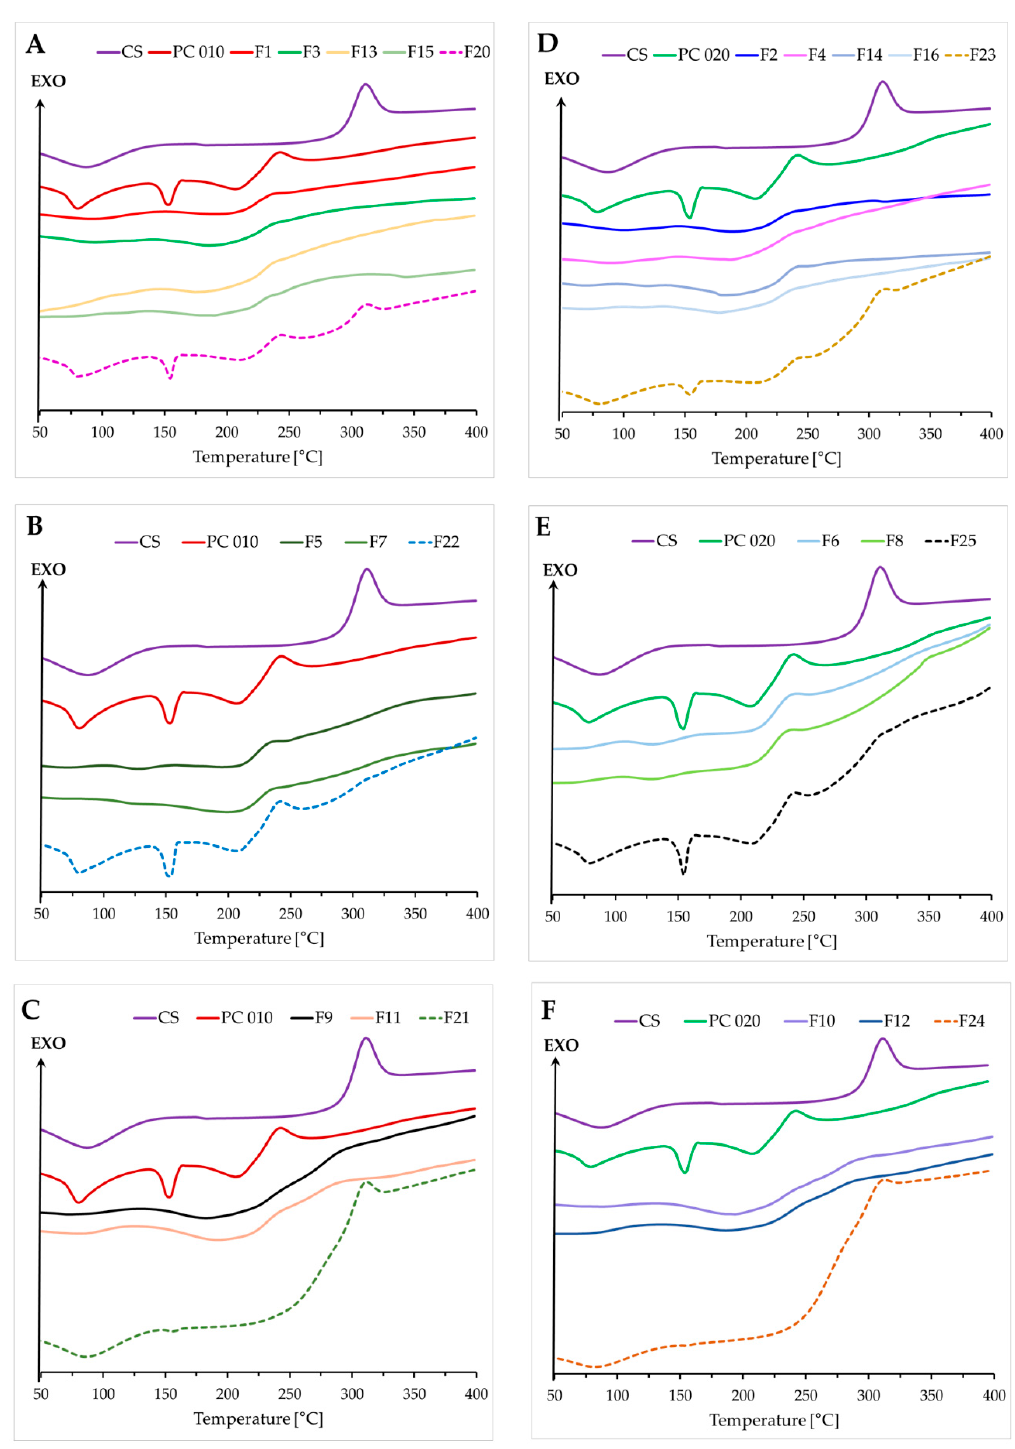
Figure 7. DSC curves for “pure” polyelectrolytes (CS, PC 010, PC 020), the films F1–F16, and the corresponding physical mixtures (F20–F25) ( A – F ).